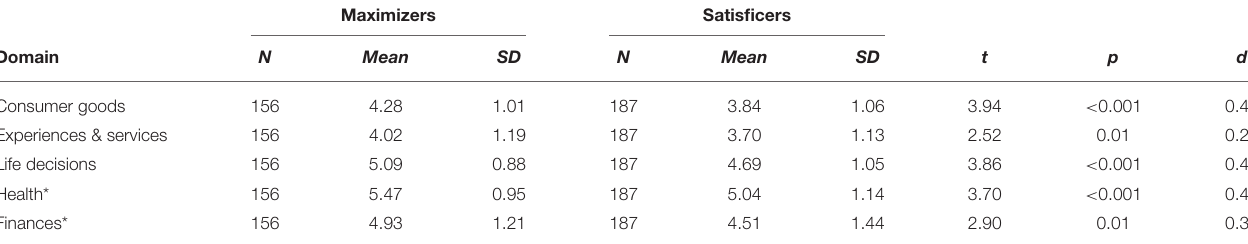
TABLE 2 | Comparison of means by decision domains between maximizers and